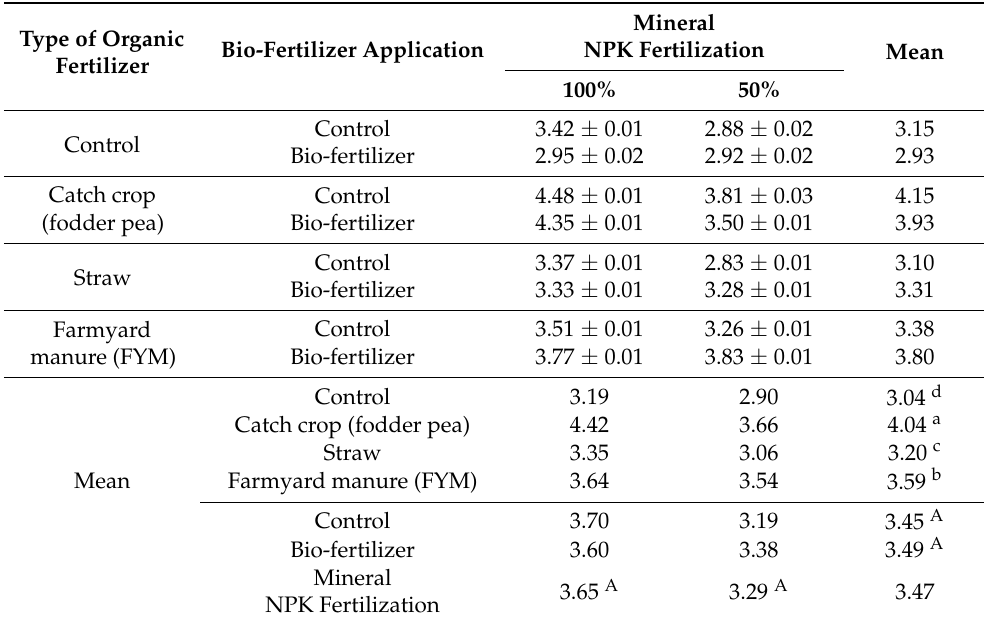
Table 7. Chlorogenic acid content in potato tubers after harvest depending on the applied research factors (g · kg − 1 DM) (mean from 3 years).